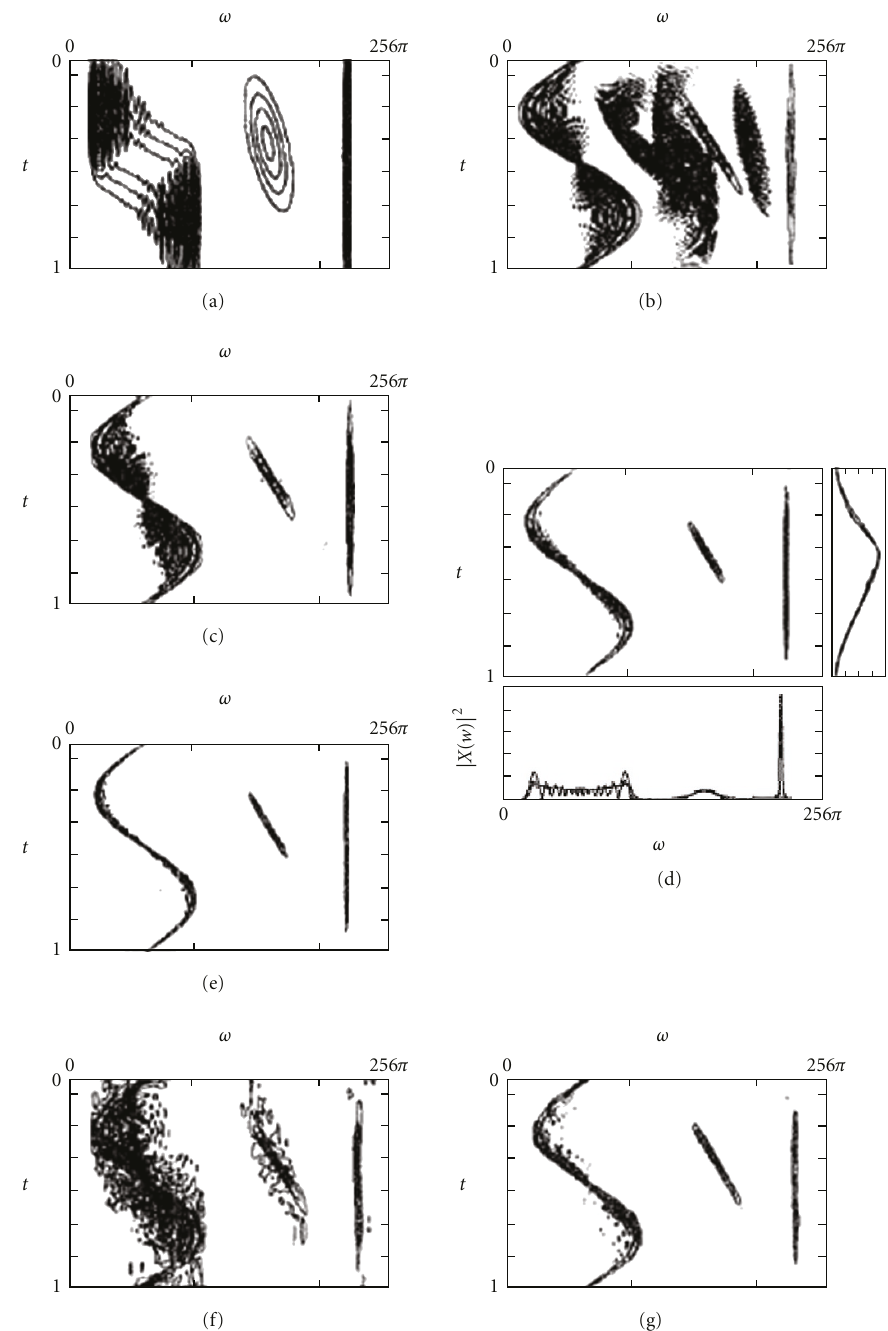
Figure 7: TFD of a multicomponent signal: (a) the spectrogram, (b) the WD, (c) the S-method, (d) the S-distribution with L = 2, including marginal properties, (e) the S-distribution with L = 2, (f) the S-method of noisy signal, (g) the S-distribution with L = 2 of noisy signal (adopted from Stankovi´c